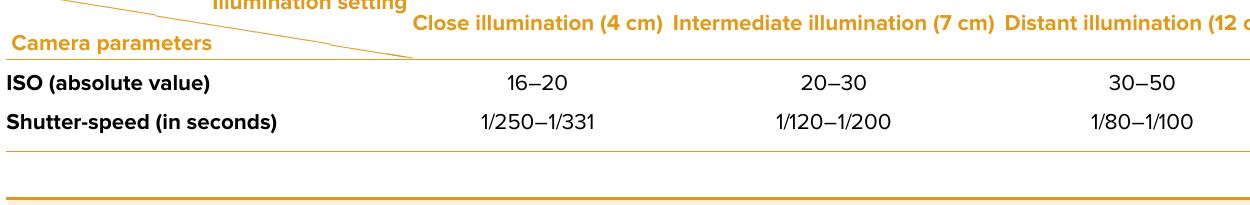
Table 3. EXIF data for the images obtained at the focusing distance from the Native camera app on iPhone X